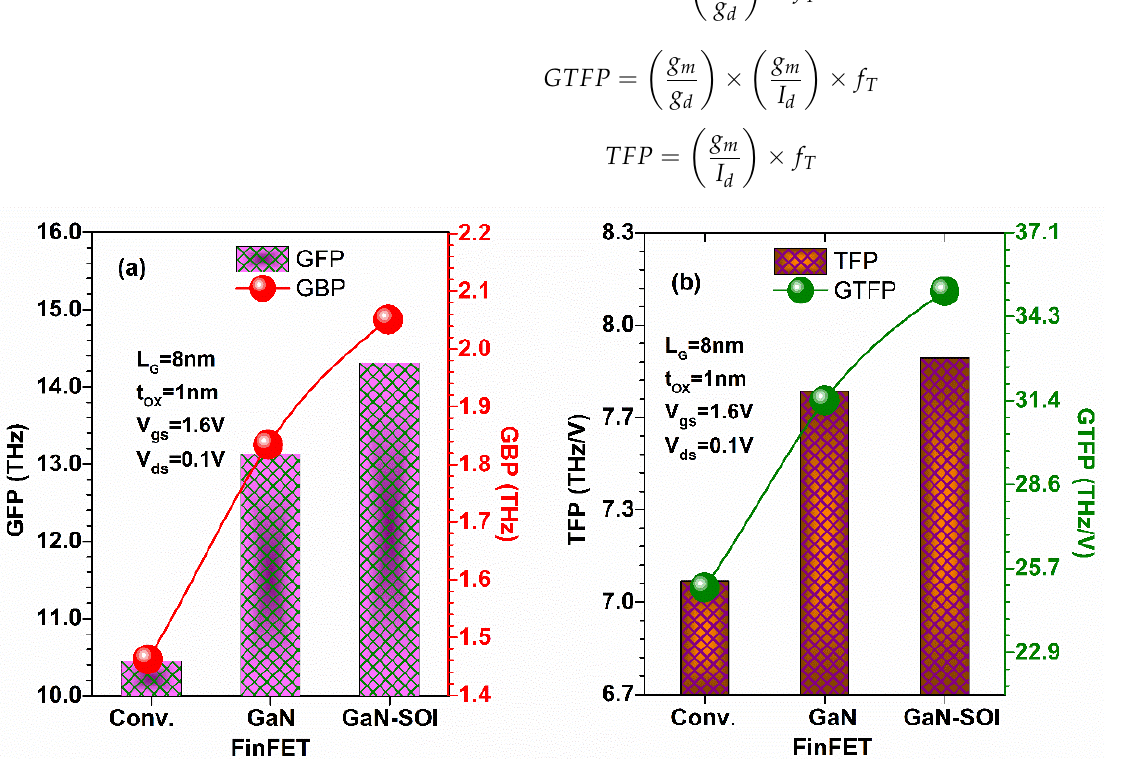
Figure 9. ( a ) GFP and GBP for GaN-SOI, GaN, and Conv. FinFETs. ( b ) TFP and GTFP for GaN-SOI, GaN, and Conv. FinFETs.